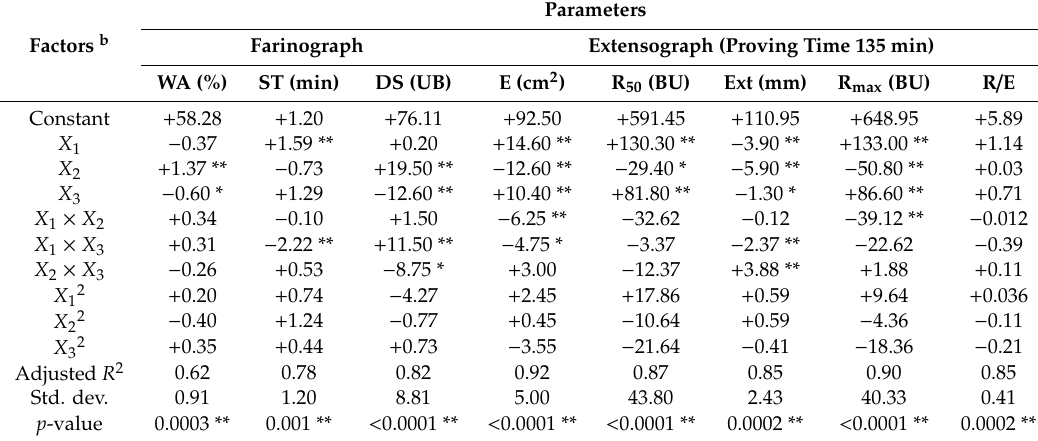
Table 4. The e ff ects of independent variables (SS, SD and FS), expressed as their coe ffi cients on the predictive mathematical models for the rheological parameters of the dough during mixing and extension of sea salt–dry sourdough–fermented sugar mixtures.